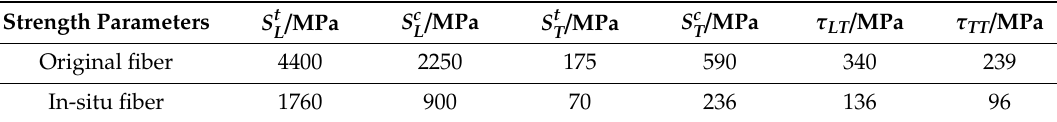
Table 6. Strength parameters of the original and in-situ